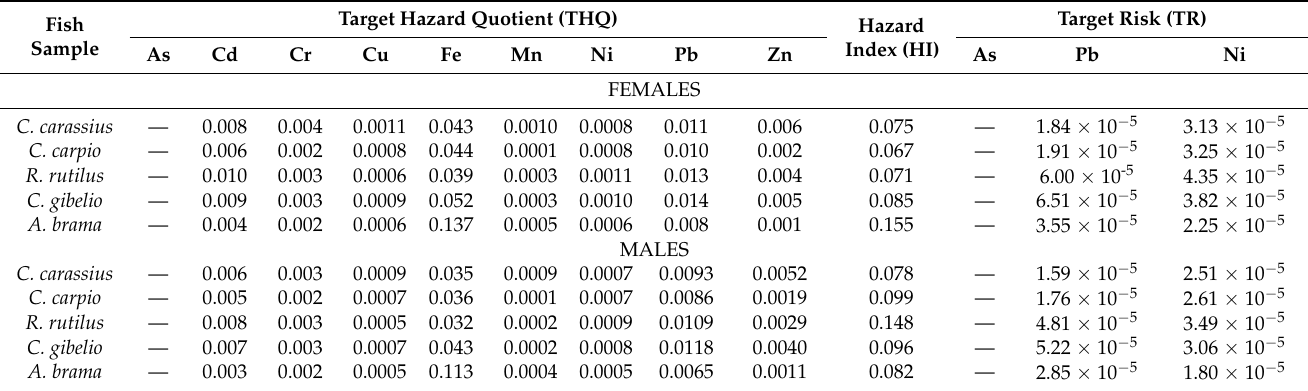
Table 5. Risk values (THQ, HI and TR) of each metal contaminant in muscle of five freshwater fish species from lakes near the Black Sea